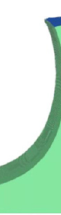
Figure 4. Simulation of the intermediate wall using a concrete model.